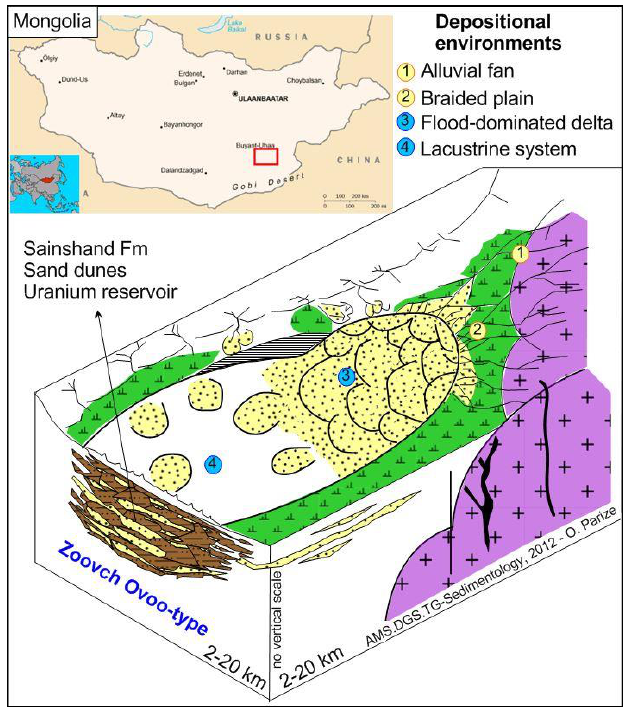
Figure 1. Location map of the study area and depositional model of the Zoovch Ovoo depocenter in the Cenomanian [26]. The sedimentary depositional systems are fluvio-lacustrine with alluvial fans, braided rivers and deltas. The sands of the Sainshand Formation host uranium mineralization.